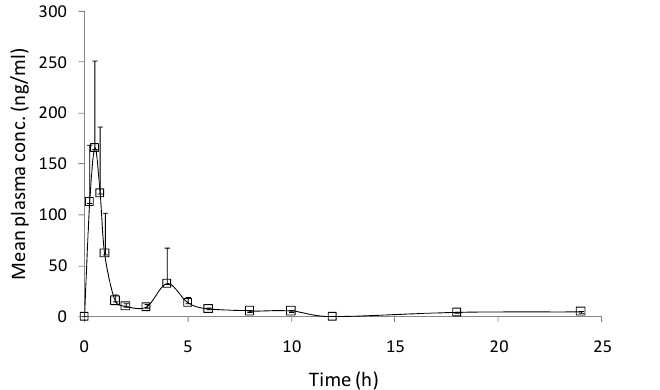
Figure 3. Mean plasma CRM concentration vs . time profile obtained after oral administration of CRM-LF to human volunteers at a dose of 750